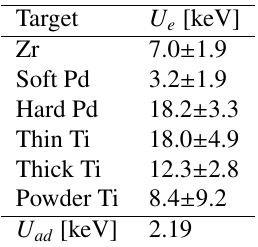
Figure 2. Integrated enhancement factors as a function of the fluorine beam energy in the center-of-mass system for the 2 H( 19 F,p) 20 F reaction obtained in three Ti targets (upper panel), and in the Zr and two Pd targets (lower panel). Points represent experimental data and the solid lines represent least-squares fits to the data.